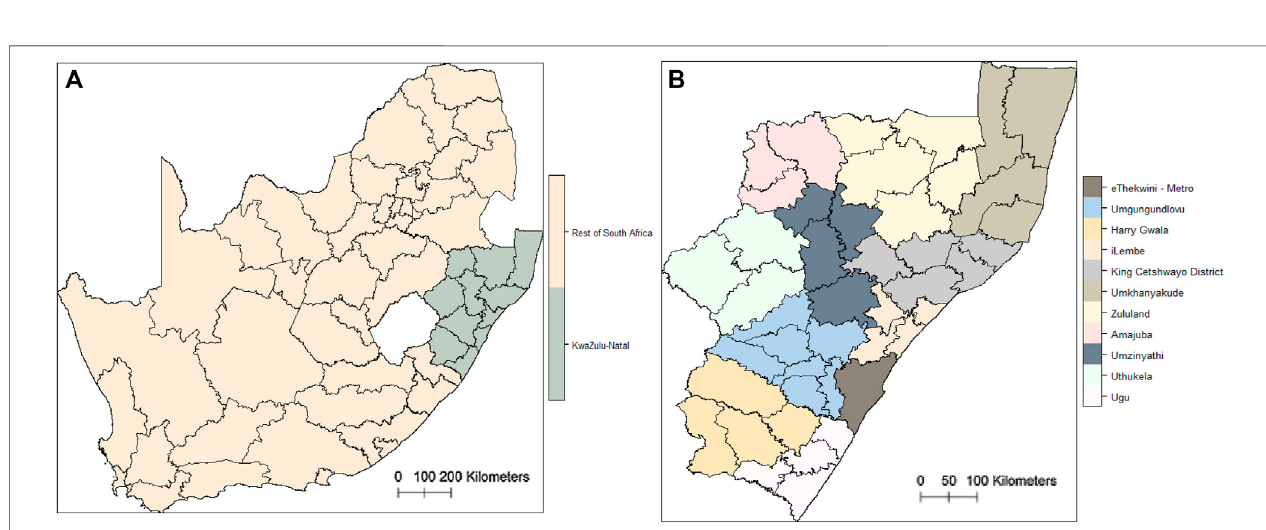
FIGURE2|(A) LocationofKwaZulu-NatalinSA.Districtmunicipalitybordersareshown. (B) DistrictmunicipalitiesinKwaZulu-Natal.Localmunicipalitybordersare shown. Data: Of fi cial shape fi les from the South African Demarcation Board (2016).